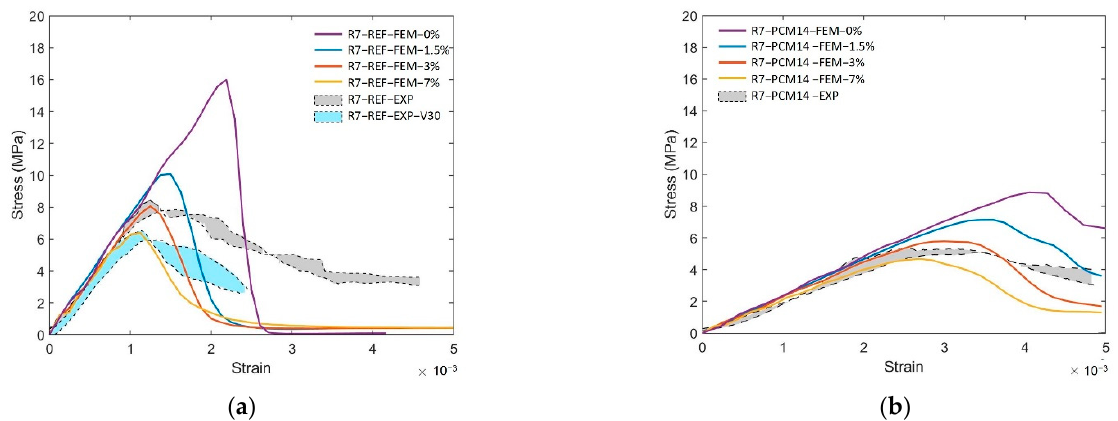
Figure 21. Comparison between experiment results and simulated results of ( a ) R7-REF specimens with different air content and vibration time and ( b ) R7-PCM14 specimens with different air content.